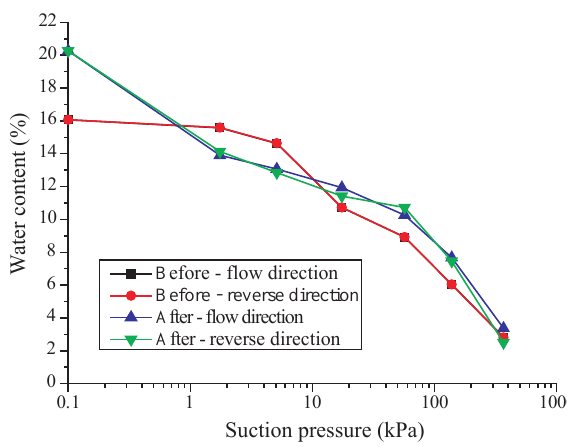
Figure 3. Retention curves before and after the dissolution experi- ment for sample